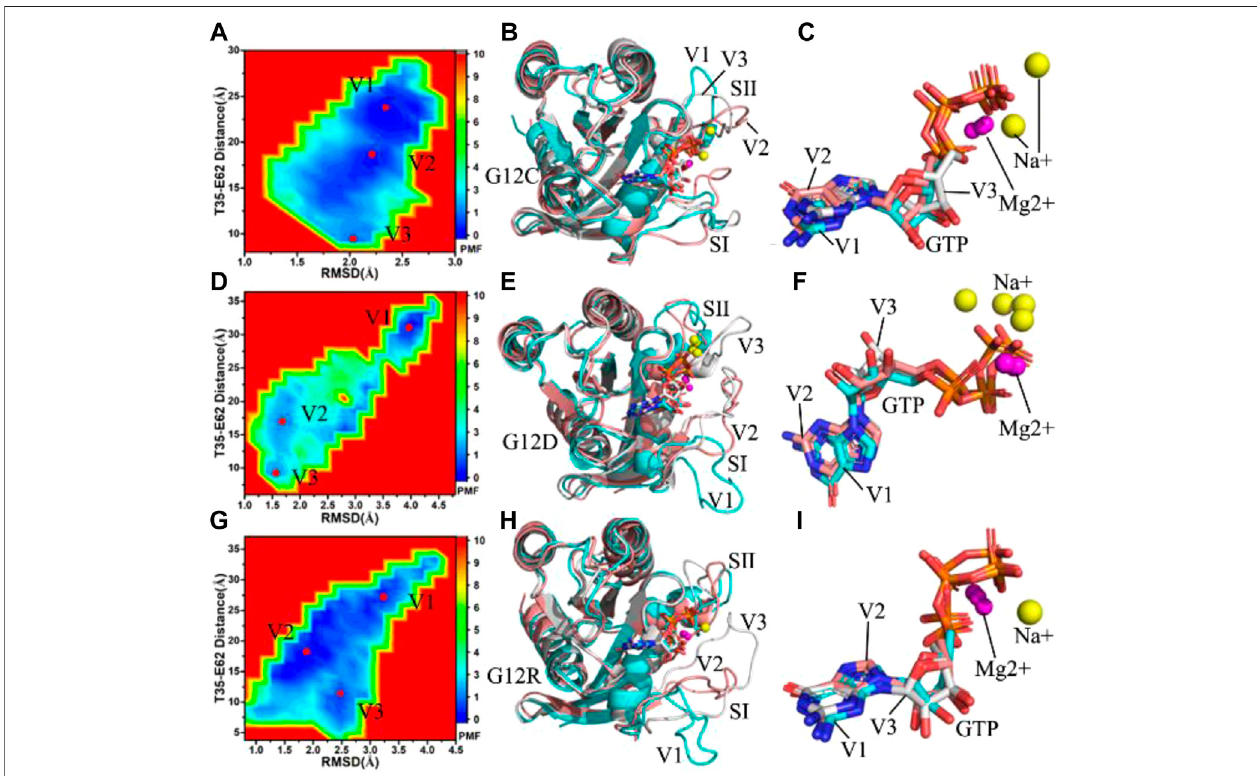
FIGURE2| Freeenergylandscapesandstructuralinformation: (A , D,G) respectivelycorrespondingtofreeenergylandscapesoftheGTP-boundG12C,G12Dand G12RKRAS, (B , E,H) separatelyindicatingstructuralsuperimpositionsoftheGTP-boundG12C,G12DandG12RKRASsituatedatenergeticvalleysV1,V2andV3and (C,F,I) respectively showing structural alignments of GTP and magnesium ions Mg2+ from the GTP-bound G12C, G12D and G12R KRAS located at energetic valleys. KRAS, GTP, magnesium ions Mg2+ and sodium ions Na+ are displayed in cartoon, stick, ball and ball modes,